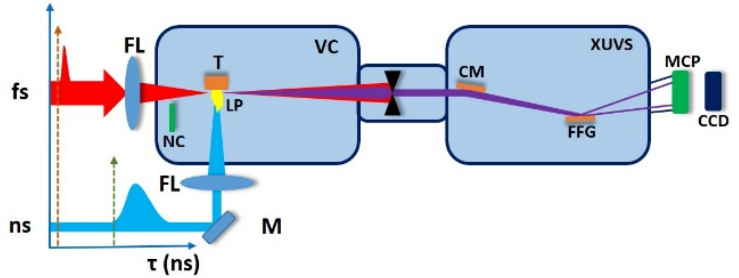
Figure 10. Experimental setup of harmonic generation in the LIP containing QDs. Reprinted with permission from Ref. [43], 2018, Optica Publishing Group.